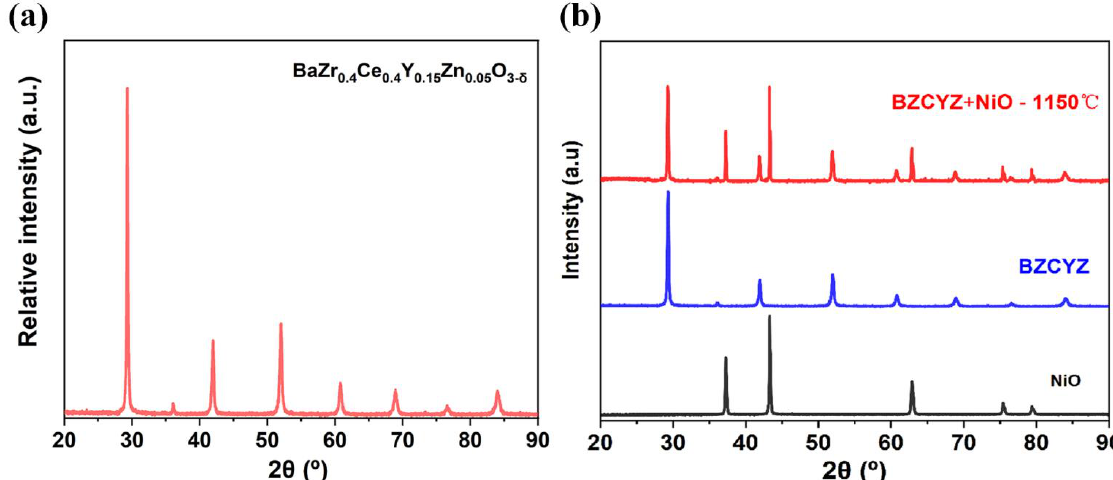
Figure 1. ( a ) Powder XRD pattern of the BZCYZ sintered at 1150 ◦ C for 10 h. ( b ) Chemical compati- bility test between BZCYZ and NiO at 1150 ◦ C for 2